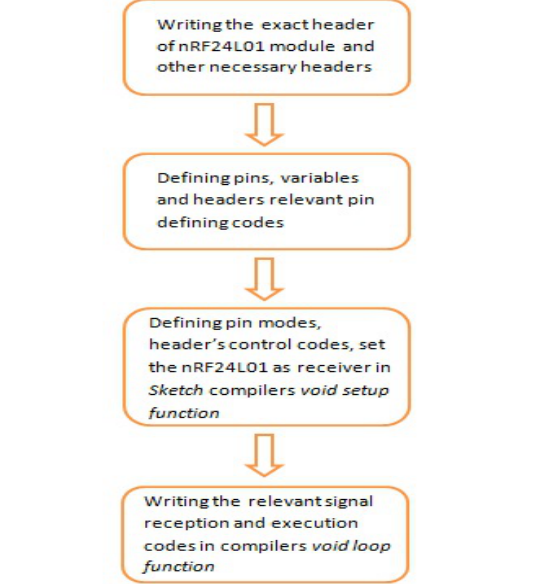
Fig. 17. Programming flow chart of